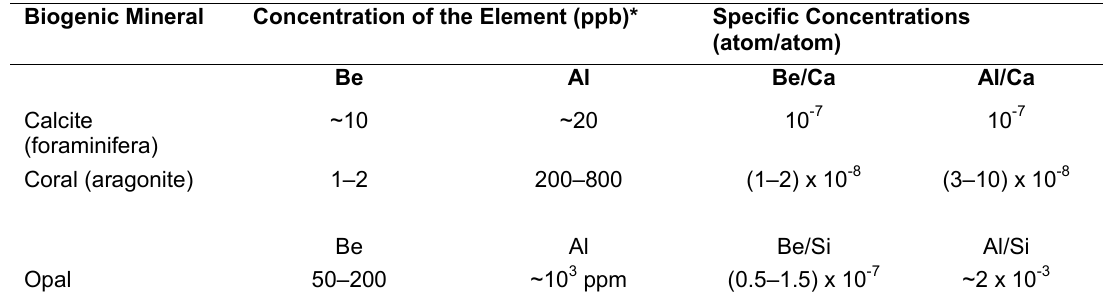
Measured Intrinsic Concentrations of Be and Al in the Three Biogenic Marine Minerals Biogenic Mineral Concentration of the Element